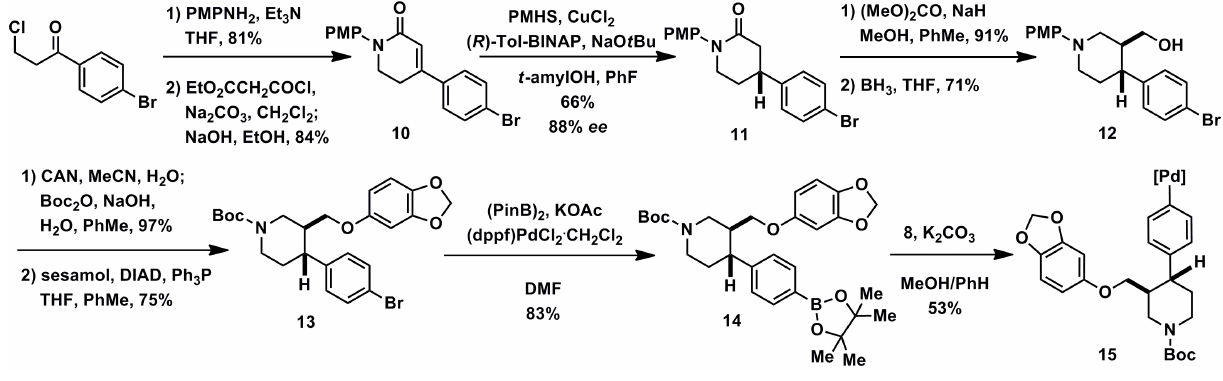
Figure 5. Synthesis of palladium(II) aryl substrate 15.